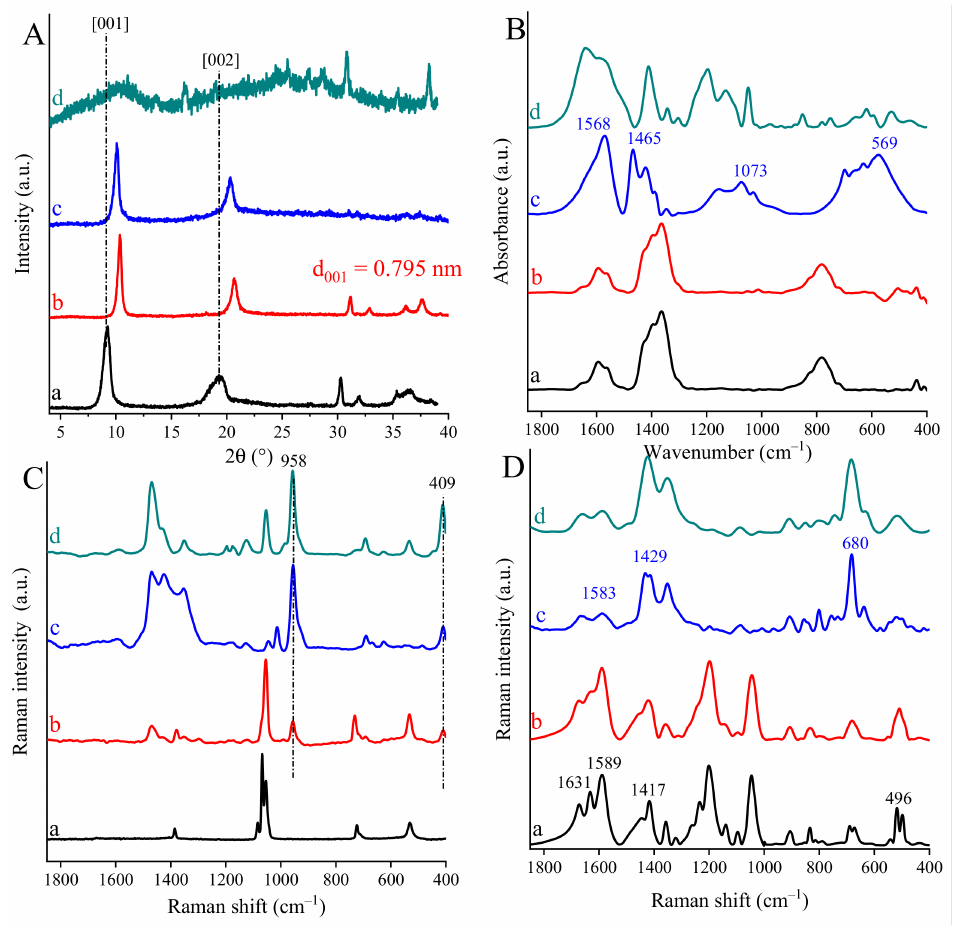
Figure 4. XRD patterns ( A ), IR ( B ) and Raman spectra ( C ) of CaAl–cysteinate–LDH (a) and CaAl– cysteinate–LDH (0.1 g) oxidized by peracetic acid using 0.4 M (b), 0.55 M (c) and 0.70 M (d) peracetic acid in methanol (100 cm 3 ). Raman spectra ( D ) of cysteine (1 g) oxidized by peracetic acid (0.4 M) in methanol (100 cm 3 ) with (a) or without (b) LDH (0.1 g) as additive as well as in acetone (100 cm 3 ) with (c) or without (d) LDH (0.1 g) as additive at 298 K. The reaction time was 60